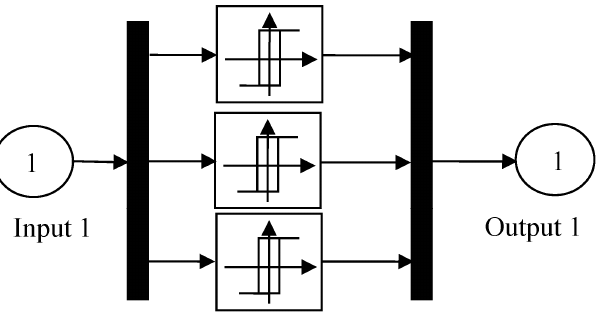
Figure 4. Traditional hysteresis controllers.